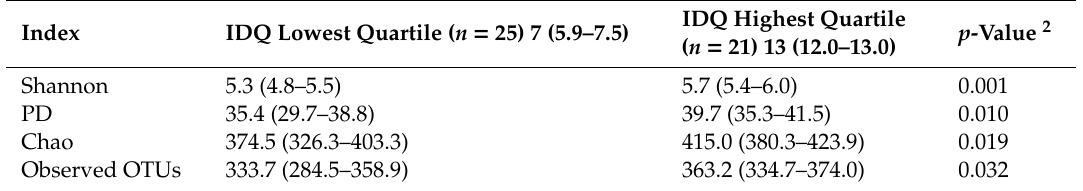
Table 2. Gut microbiota diversity indexes in the lowest and the highest diet quality score (IDQ) quartile 1 .